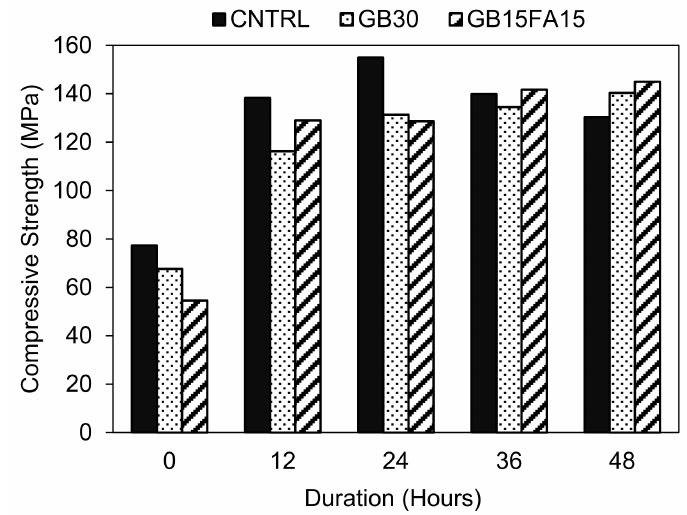
Figure 4. 12 h HAC compressive strength development.